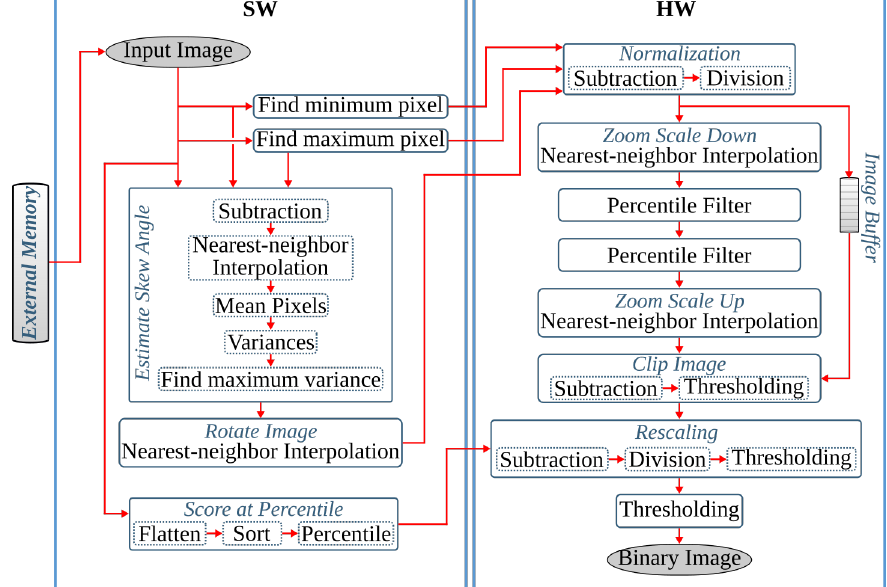
Figure 10. Hardware-software partitioning of the binarization process for the i DocChip